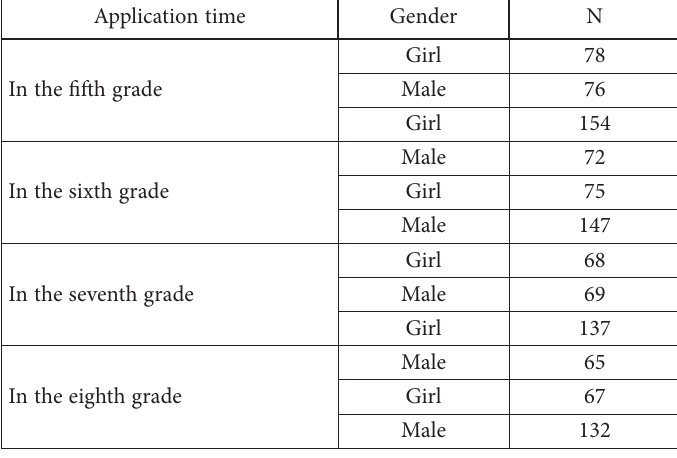
Table 1. Distribution of sample by sex by years (source: created by